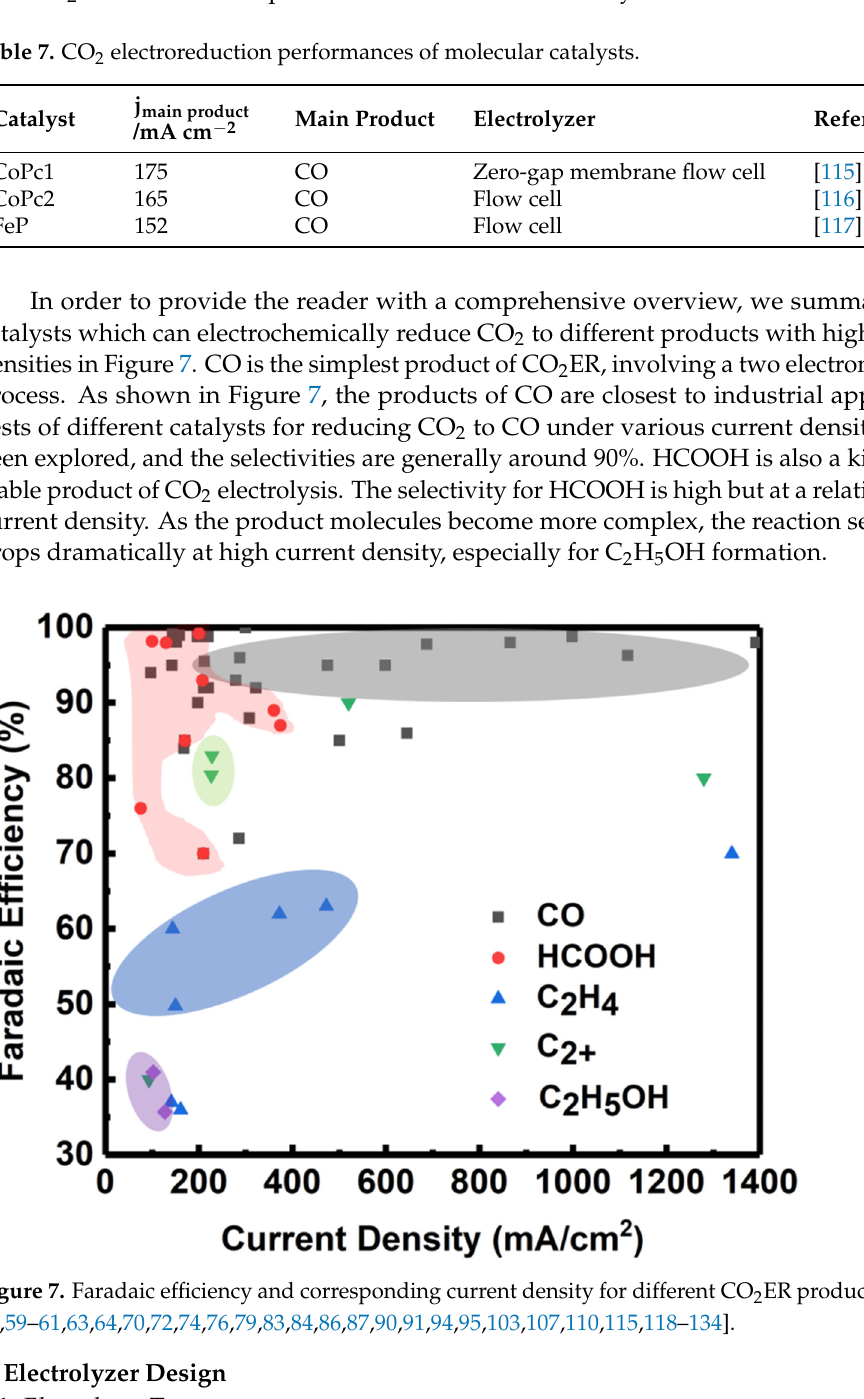
Figure 6. Structure of: ( a ) cobalt phthalocyanine catalyst CoPc1; ( b ) CoPc2. ( c ) FE CO and j CO of CoPc2 vs. potential. Reproduced with permission from Ref. [116]. Copyright 2019 Springer Nature Limited. ( d ) Structure of FeP; ( e ) j CO and FE CO of FeP vs. potential. Reproduced with permission from Ref.